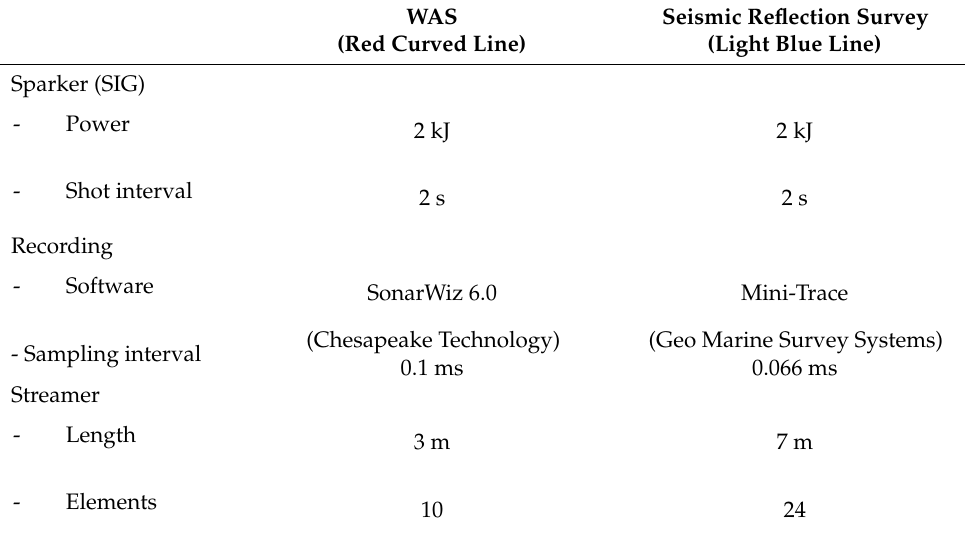
Table 2. Survey equipment and data acquisition parameters.